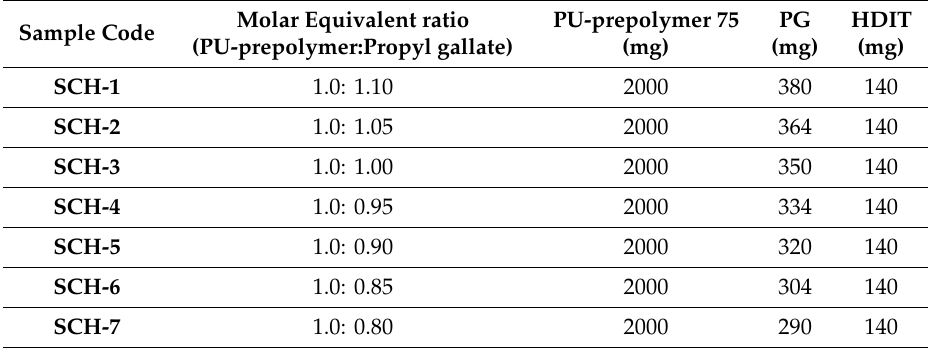
Table 1. Formulations of the samples prepared in this